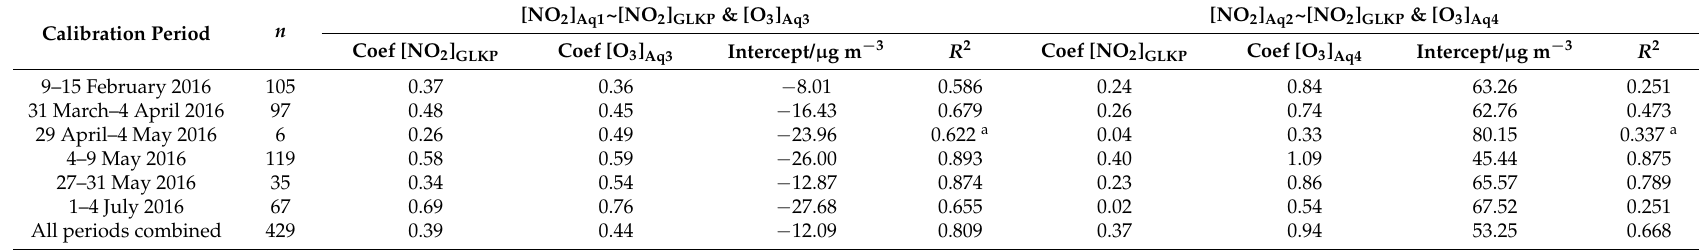
Table 5. Regression statistics of Aeroqual NO 2 monitor concentrations ([NO 2 ] Aq1 and [NO 2 ] Aq2 ) against the reference analyser ([NO 2 ] GLKP ) and the co-located Aeroqual O 3 monitor ([O 3 ] Aq3 and [O 3 ] Aq4 ) at Glasgow Townhead AURN monitoring station (hourly averages) for individual co-location periods and for all periods